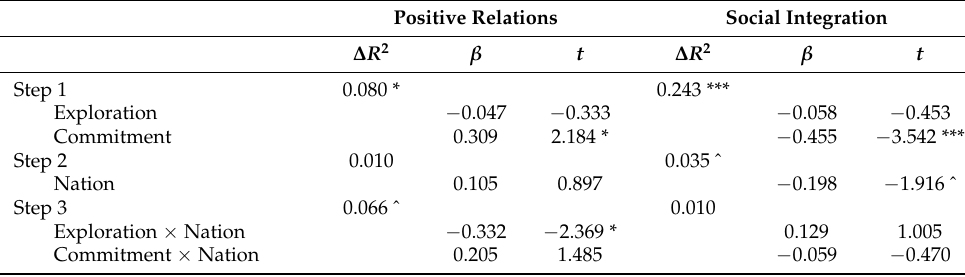
Table 2. Moderator analysis: dimensions of private and public eudaimonic